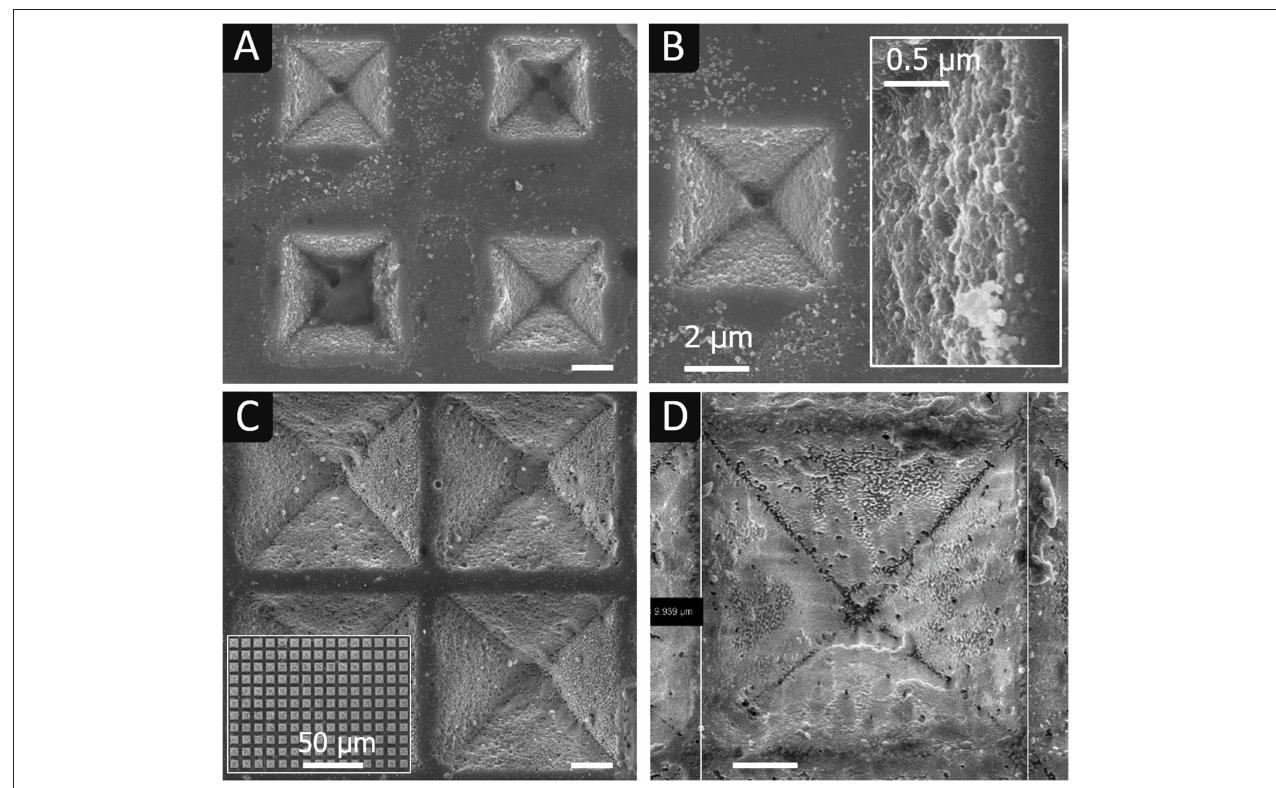
FIGURE 4 | SEM images of silicon surfaces after imprinting inverted pyramids with a fine (A,B) and a coarse (C,D) np-Au electrode. Electrochemical contact etching was carried at 0.3 V SME for 10min (A,B) ; at 0.3 V SME for 20min (C) and at 0.2 V SME for 20min (D) . Insets: (B) inverted pyramid border at higher magnification; (C) inverted pyramid array at lower magnification. Electrolyte: HF 5mol L − 1 with 2 vol.% EtOH. Scale bars: 2 µ m unless otherwise noted.